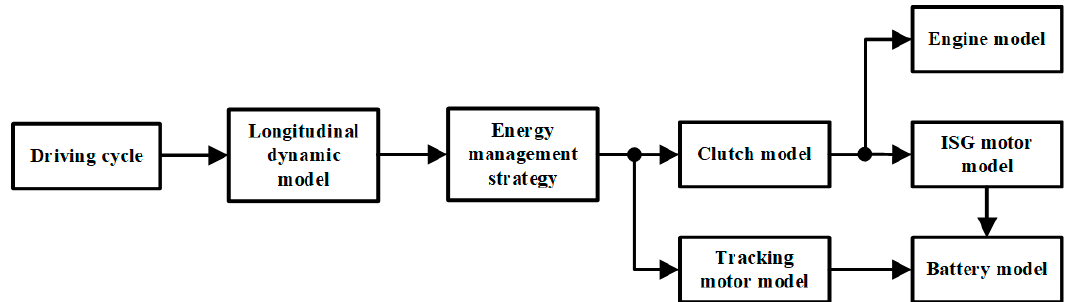
Figure 8. Backward simulation flowchart for series-parallel PHEV.